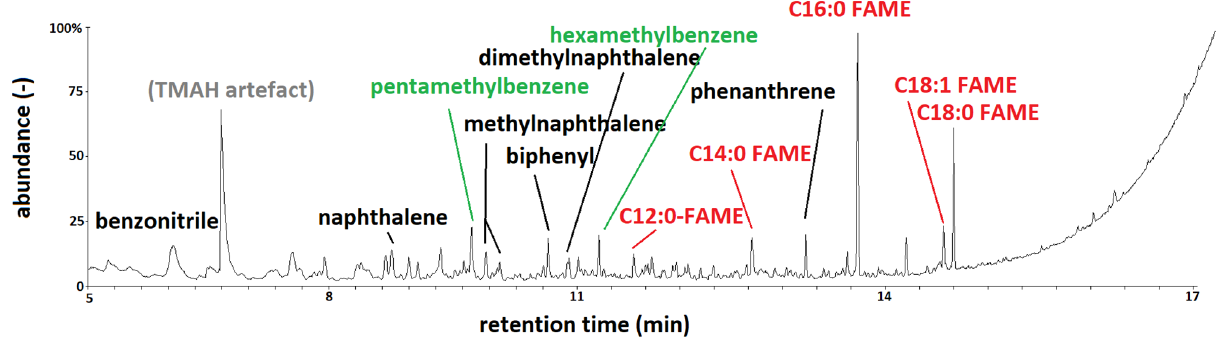
Figure 3. Example chromatogram (sample CAM4A-100) showing products of fatty acids (FAMEs, in red), polyalkylaromatic compounds (green) and polycyclic aromatic hydrocarbons (black).